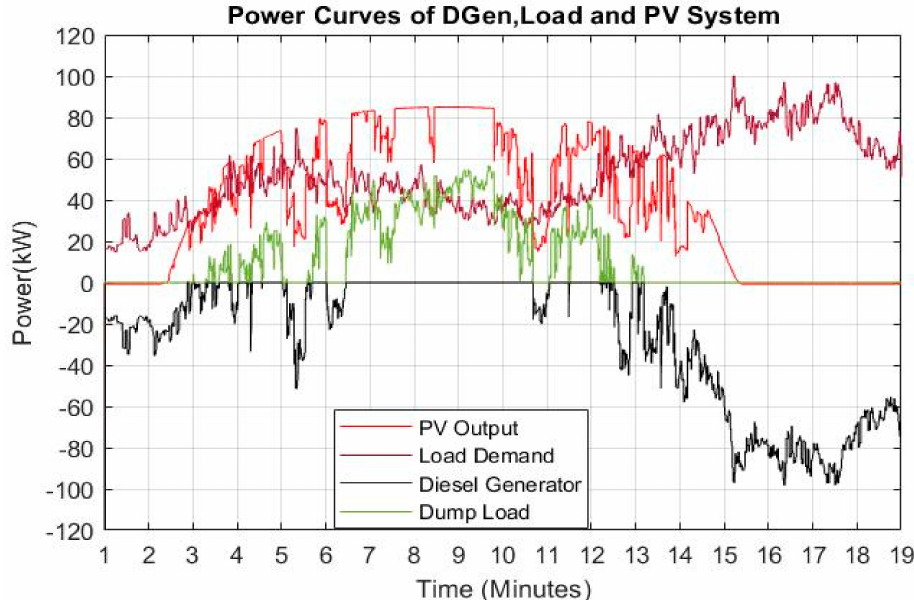
Figure 12. Power curves of solar PV, load demand and diesel